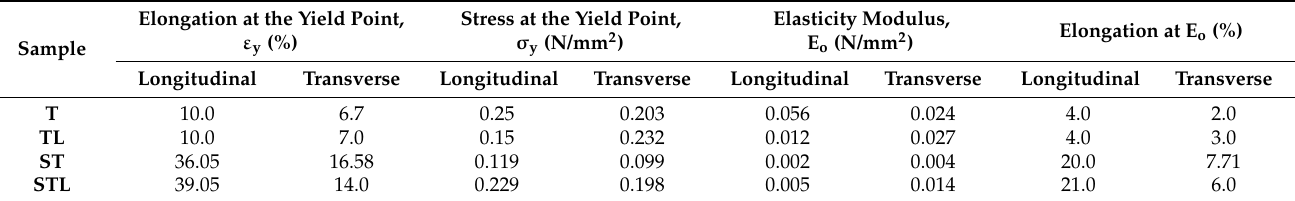
Table 5. The results of yield point and elasticity